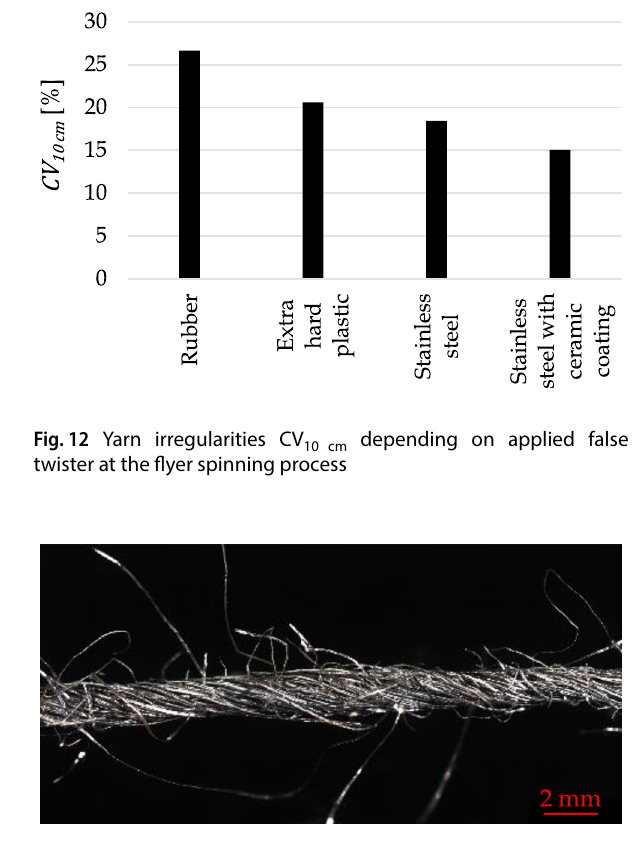
Fig. 13 Microscopic longitudinal view of flyer yarn using false twister made from stainless steel with ceramic coating